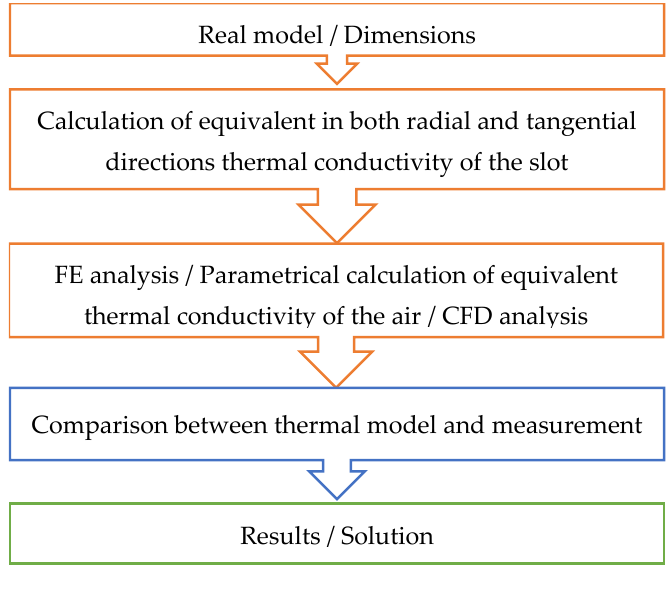
Figure 12. FEA simulation results of the obtained equivalent conductivity coefficient.